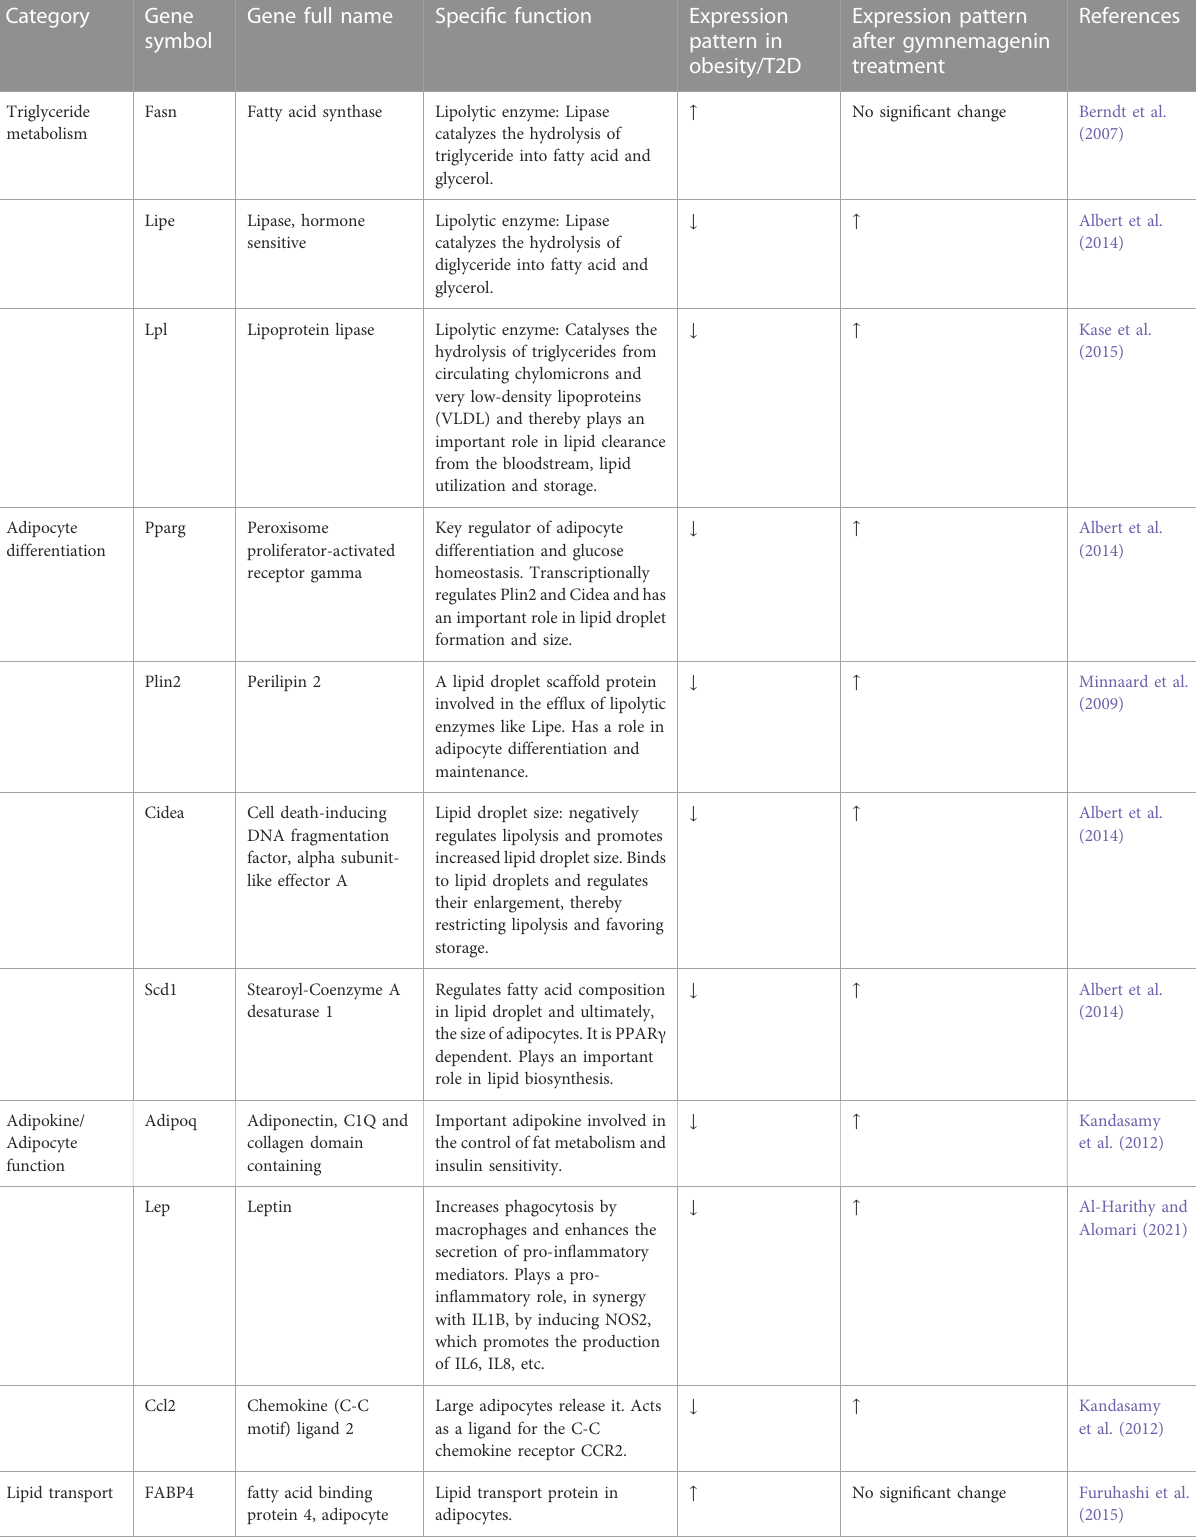
TABLE 2 Effect of gymnemagenin on the 12 gene panel of lipid metabolism and